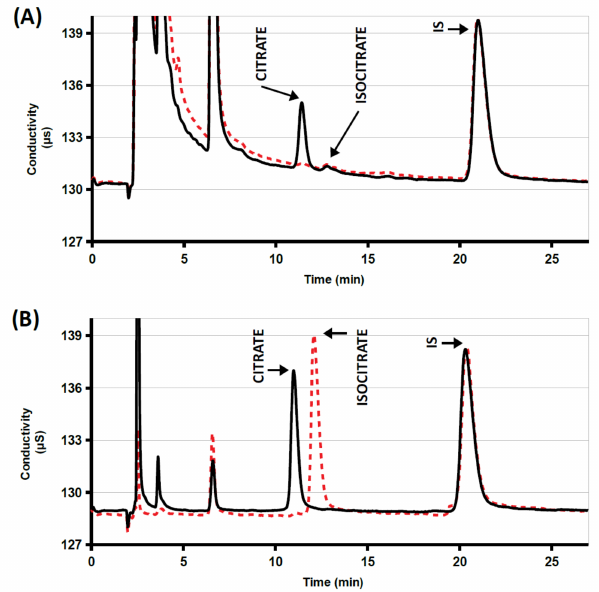
Figure 1. Chromatographic profiles for ( A ) real urine sample with a citrate concentration of 2.34 mmol/L incubated (dotted red line) or not (solid black line) in the presence of citrate lyase; ( B ) 5.20 mmol/L citrate (solid black line) and 5.20 mmol/L isocitrate (dotted red line) standard